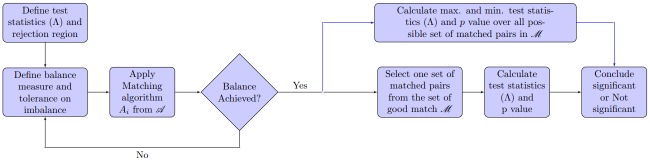
Comparison of matching for hypothesis testing under classical approach and robust approach [26].Steps before covariate balance achievement remains same for each approach. In the remaining steps, Black arrows show the classical approach, and Blue arrows show the robust approach proposed in [26].